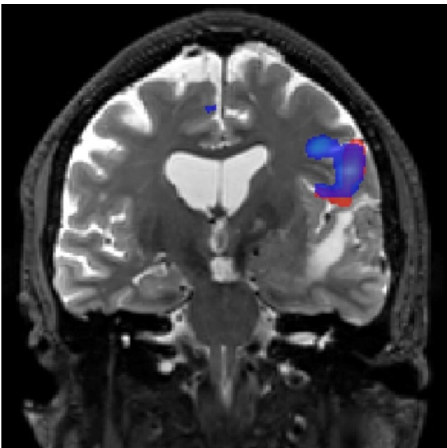
Figure 5. fMRI of activation in Broca’s area as an indicator of a left hemispheric language dominance area using verbal fluency (red) and verb generation (blue) paradigms in a patient with left temporal lobe mass. In addition, there is a superior displacement of the parenchymal area associated with language activation.